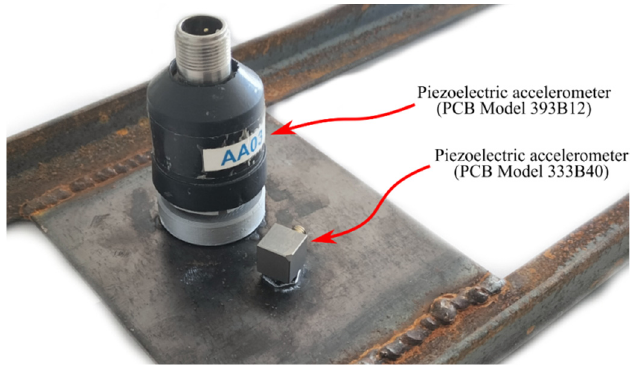
Figure 6. Two piezoelectric accelerometers fixed on the underside of the steel beam.